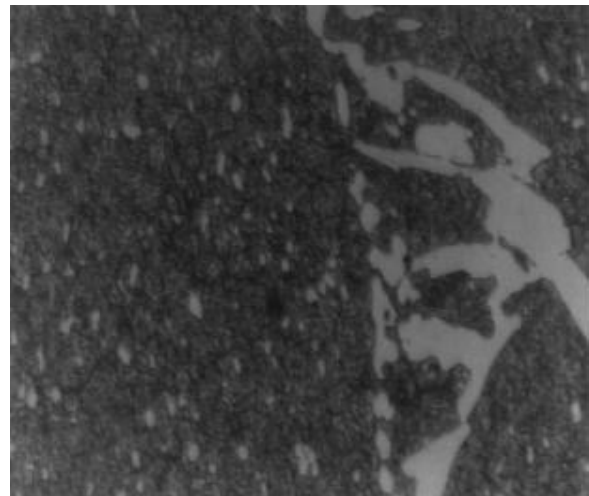
Figura 12. Ensaio 1; Z w = 3600 mm 3 /mm.